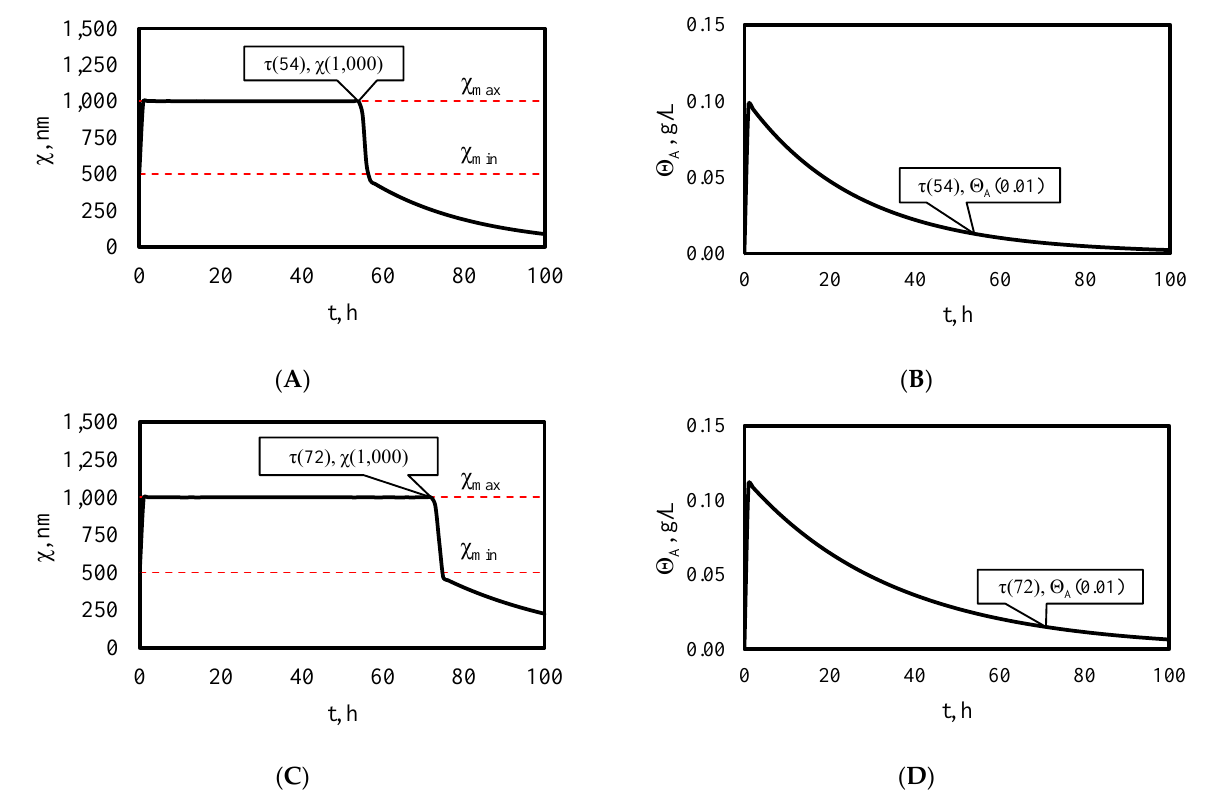
Figure 6. Route of the state of lubrication system without a regulator. ( A ) Tribofilm thickness profile for 4 L of lubricant in the oil pan, ( B ) Tribofilm thickness profile for 6 L of lubricant in the oil pan, ( C ) Profile of the difference in partial densities of lubricant precursors between the oil pan and the engine for 4 L of lubricant in the oil pan, and ( D ) Profile of the difference in partial densities of lubricant precursors between the oil pan and the engine for 6 L of lubricant in the oil pan.